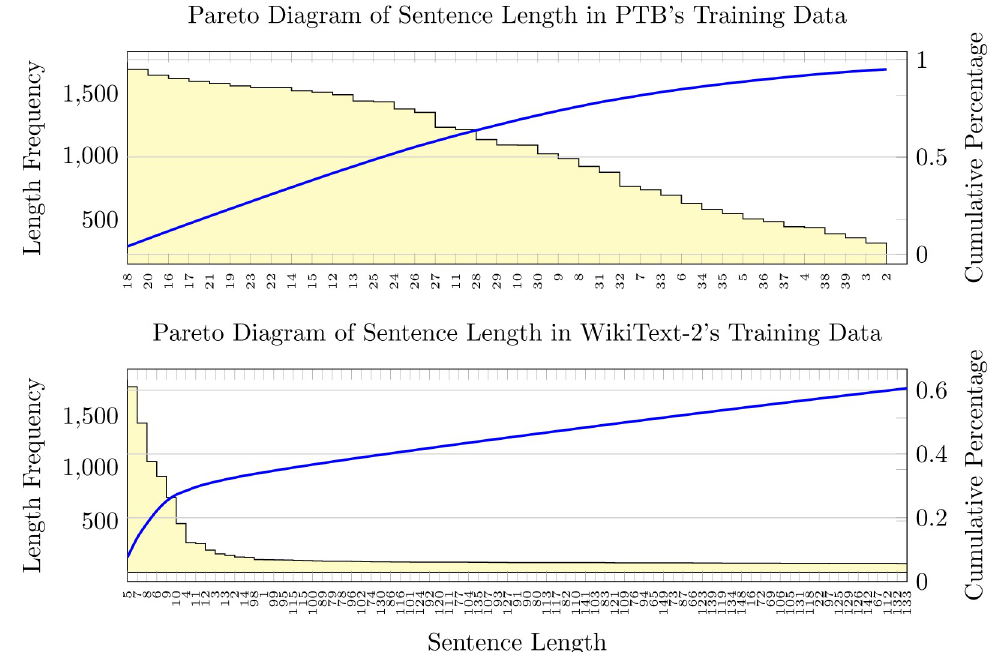
Fig 1. Pareto diagram of sentence length in corpora’s training data.